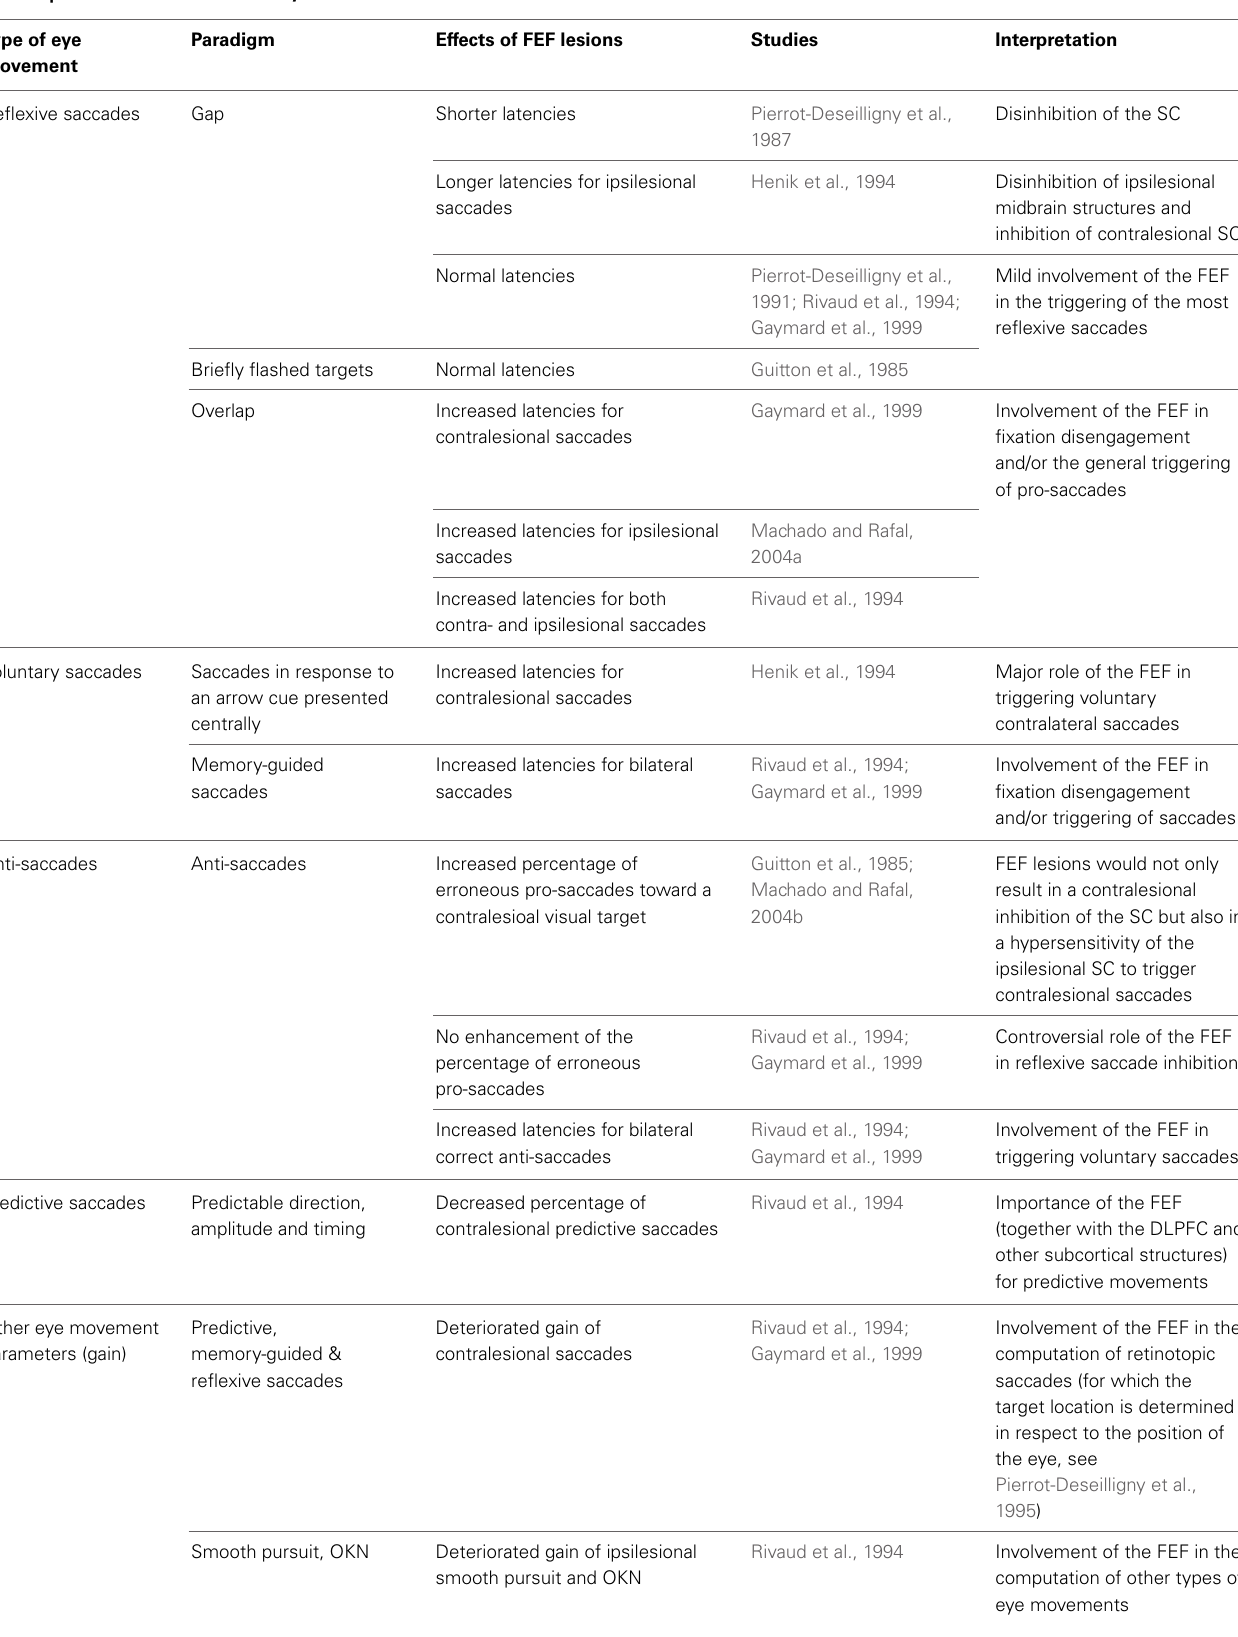
Table 4 | Effects of FEF lesions on eye